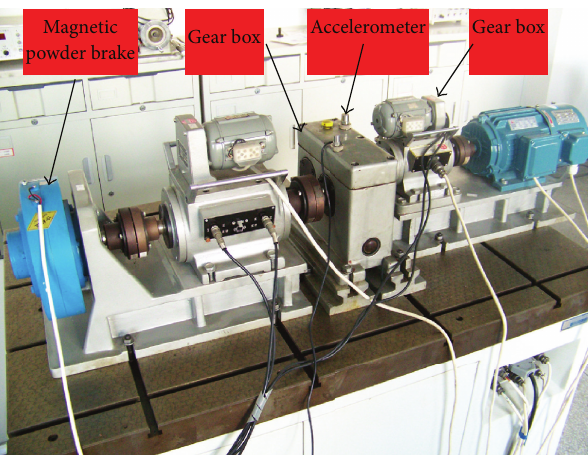
Figure 2: log 𝐹(𝑠) versus log 𝑠 of 𝑦(𝑡) , 𝑥(𝑡) , 𝑛(𝑡) , and 𝑚(𝑡) .